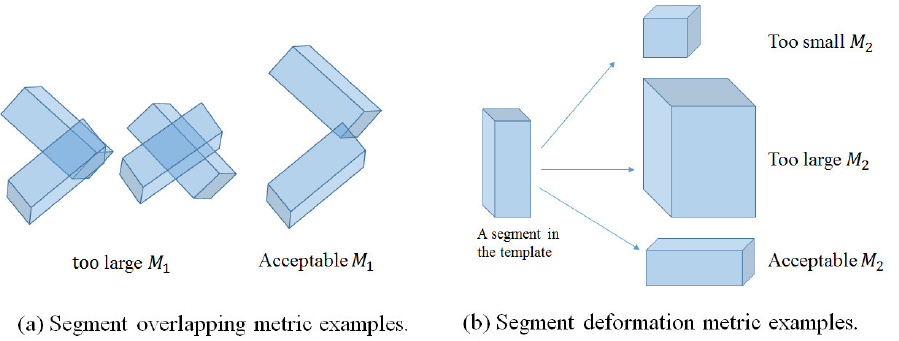
Figure 5. Illustration of two metrics used for segment volume